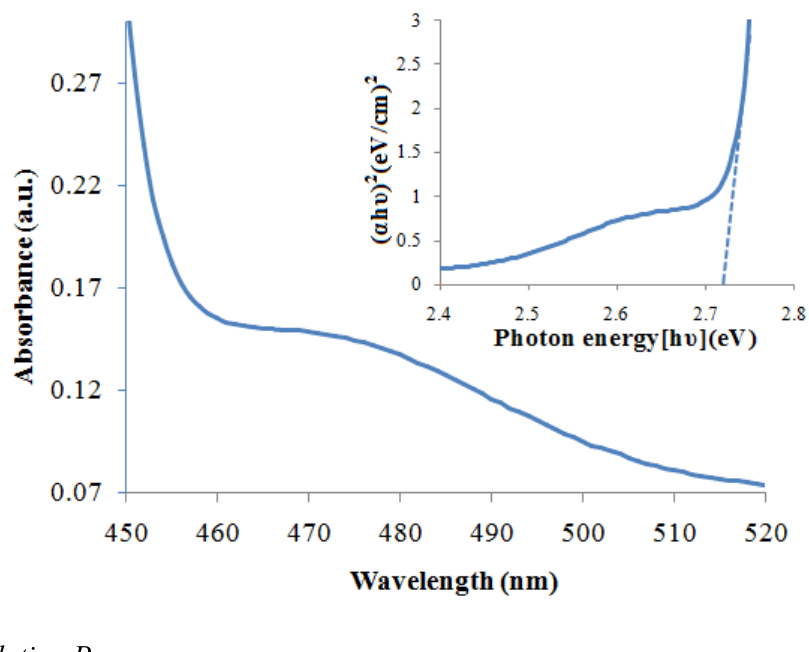
Figure 6. UV–Vis spectra and Tauc plot of the CdS